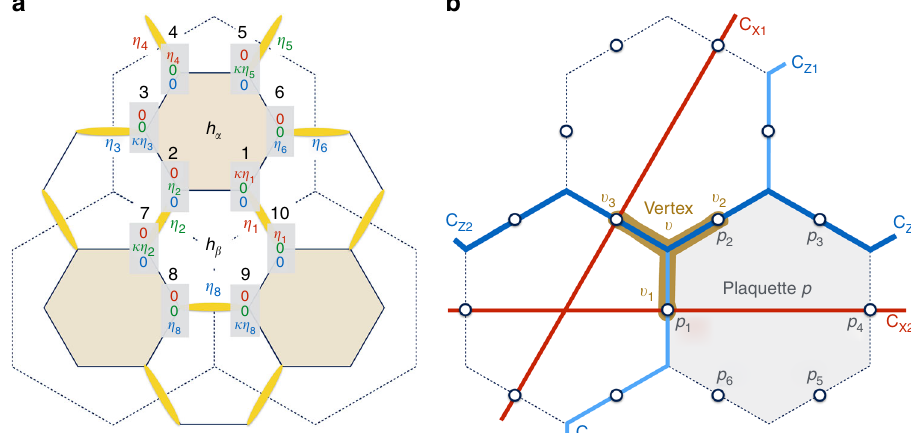
Fig. 2 The mapping to a Toric code on a honeycomb superlattice. a Star dimer pattern selected from spin waves 16 . The numbers 1 – 10 label the spin sites, and the shaded 3×1 vectors below each number give the corresponding Cartesian components. The star pattern is one of the Cartesian states of Fig. 1b, which map to dimer (yellow) coverings on the lattice. The η ’ s describe the orientation of the two spins per dimer. They sit at the middle of the bonds of a honeycomb superlattice (dashed). b The resulting Toric code description of Eq. (10) on the honeycomb superlattice. The three- and six-body operators A v and B p of Eq. (10) are de fi ned on vertices v and plaquettes p of the superlattice. These connect, respectively, three sites ( v 1 – v 3 ) and six sites ( p 1 – p 6 ) of the superlattice. For the torus geometry, C X1 and C X2 (similarly for C Z1 and C Z2 ) are non-contractible loops that wrap the system in different